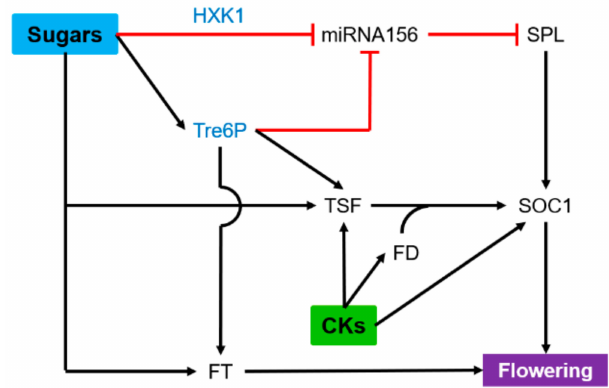
Figure 6. Synergistic effect of sugars and cytokinins (CKs) on flowering. Blue words indicate sugar signaling pathways. Black arrows and red lines indicate stimulatory and inhibitory effects, respectively. FD, FLOWERING LOCUS D; FT, FLOWERING LOCUS T; HXK1, hexokinase1; SOC1, Suppressor of Overexpression of Constans1; SPL, Squamosa Promoter-Binding Protein-Like; Tre6P: trehalose-6-phosphate; TSF, TWIN SISTER OF